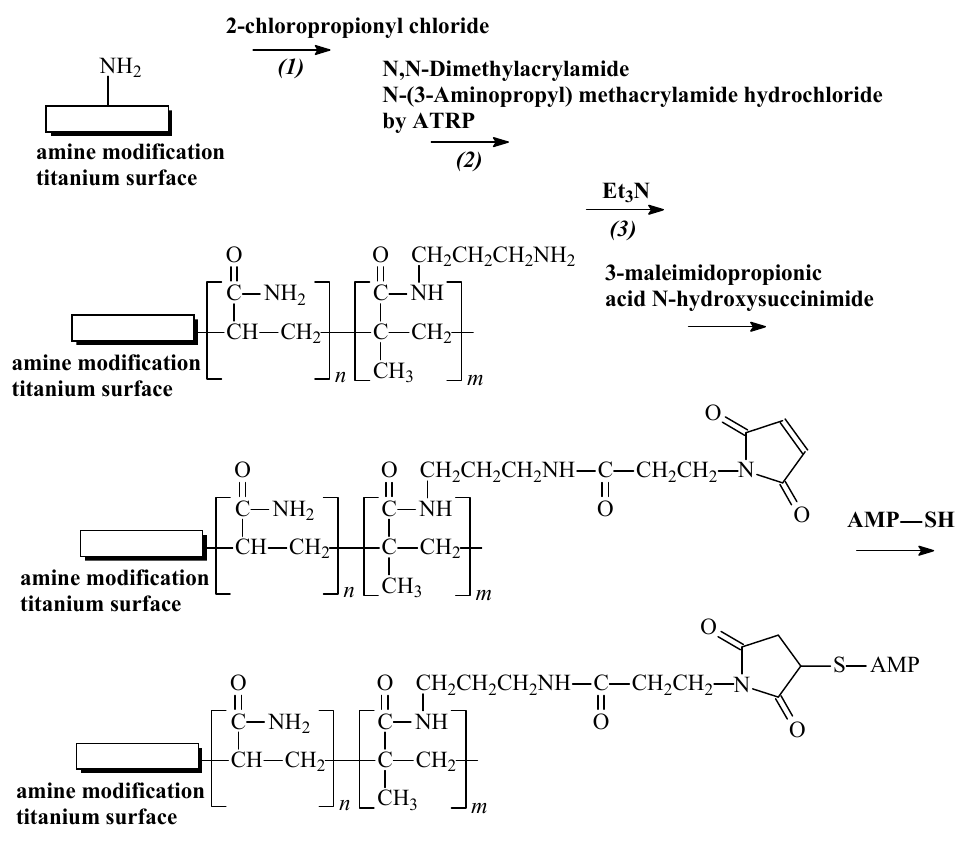
Figure 4. Synthesis of AMPs immobilized copolymer brushes on